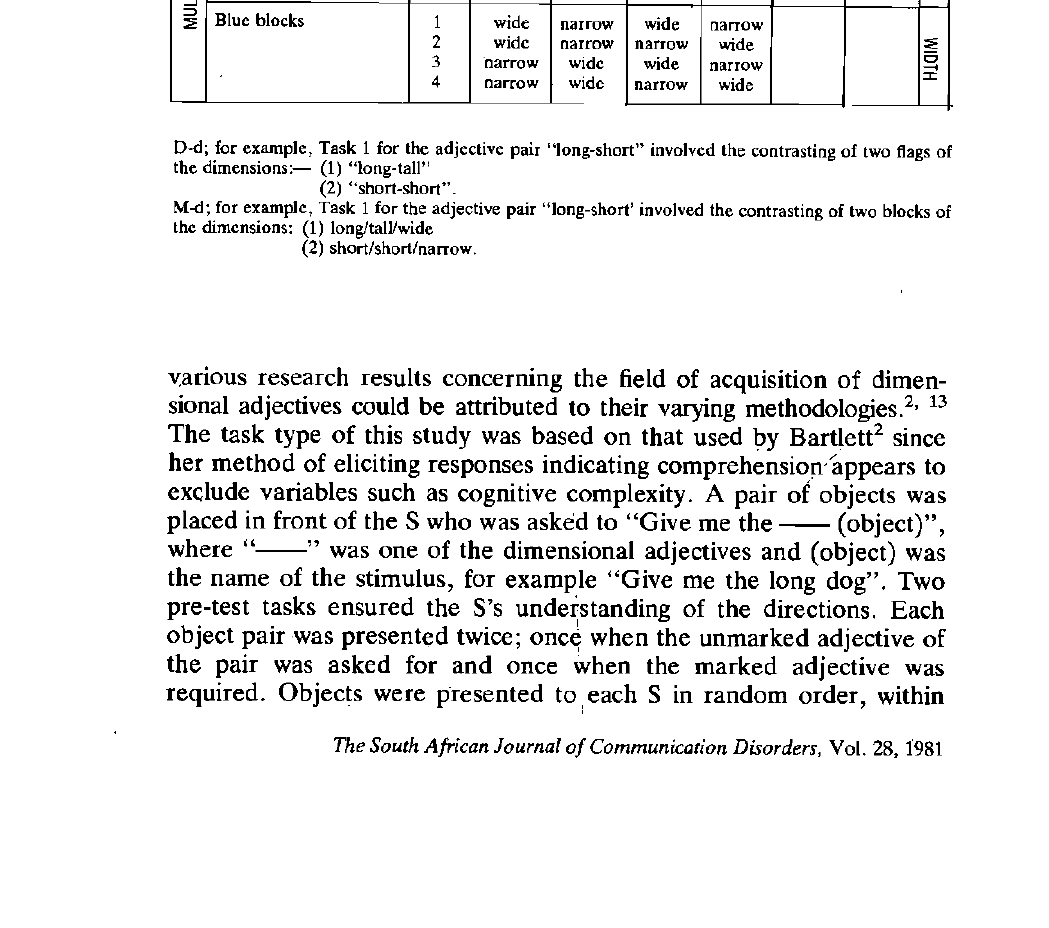
TALLNESS WIDTH (+primary) (+secondary) long short short long long short short